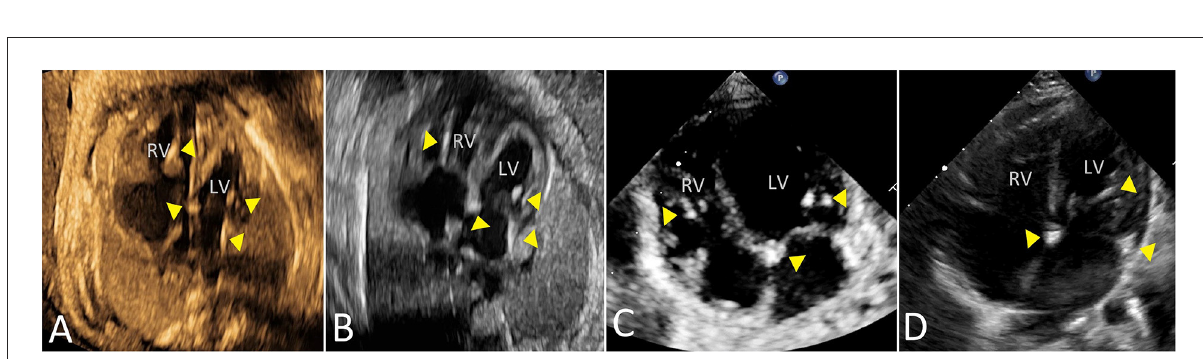
FIGURE5 The echocardiographic features of isolated mild EFE in a fetus due to maternal anti-Ro and anti-La antibodies. Triangles mark the areas of mild EFE in four-chamber view [ (A) 30 gestational weeks; (B) 33 gestational weeks; (C) 1 month; (D) 1 year]. LV, left ventricle; RV, right